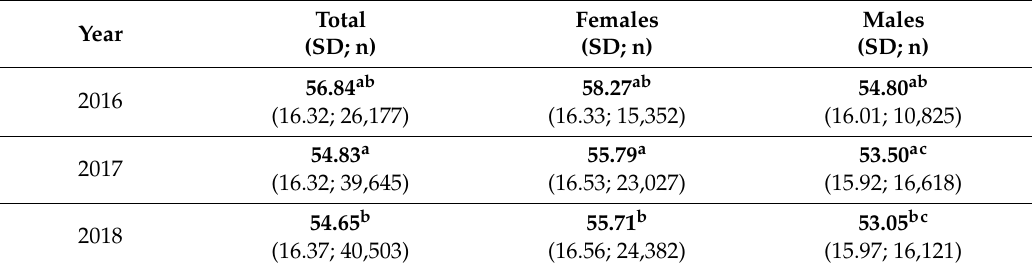
Table 1. Average age and gender of participants; assessment of the significance of di ff erences between average values in subsequent years of the